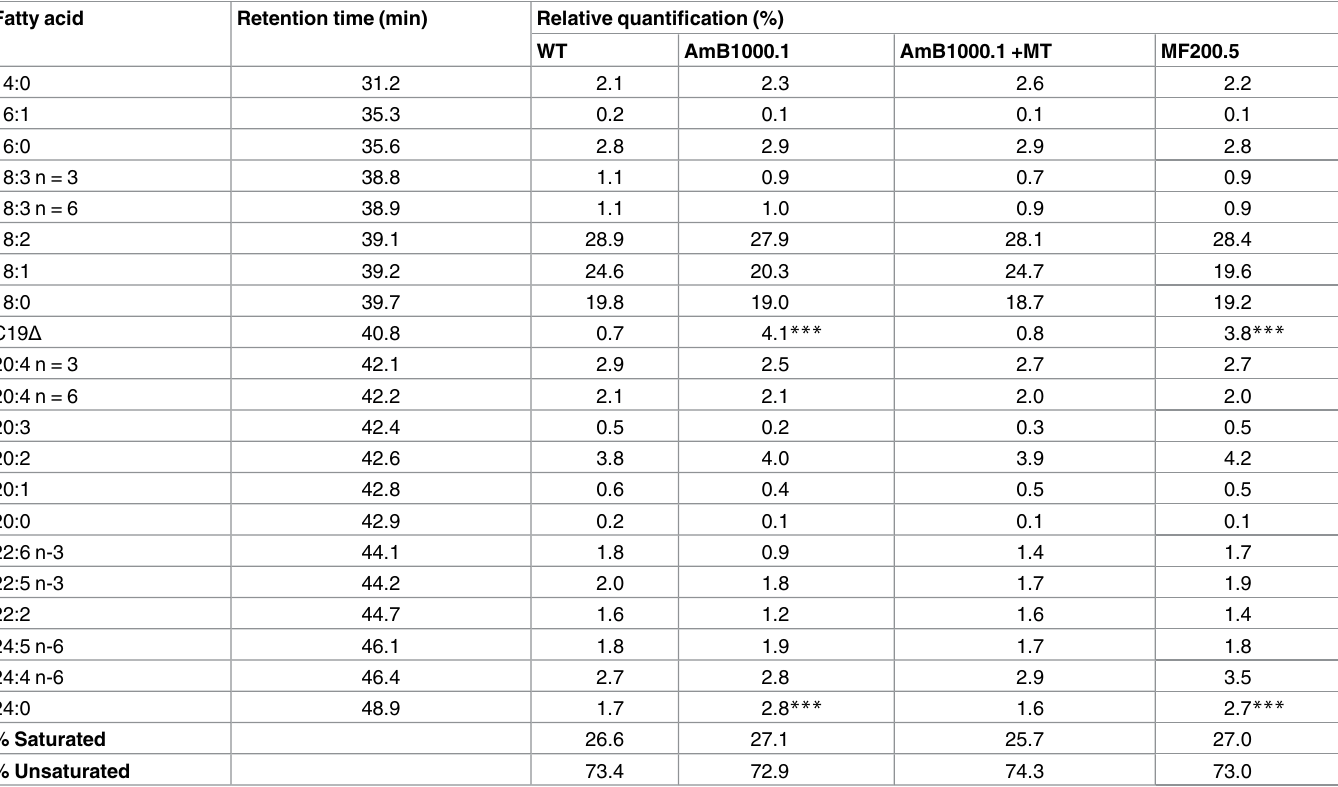
Table 2. Total fatty acid content quantification (relative %). GC-MS was used to determinethe fatty acid content of the different L . infantum strains, in comparisonwith wild-typeparasites. S7 Fig includesan examplefor total ion chromatogram of derivatised fatty acids from lipid extracts of L . infantum 263 wild-type.Data are the mean of three independentexperiments. Statistical significancebetweenthe mock-transfected wild-typeand the rest of the strains was evaluatedby unpairedtwo-tailedt test ( *** p (cid:20) 0 . 001 ).